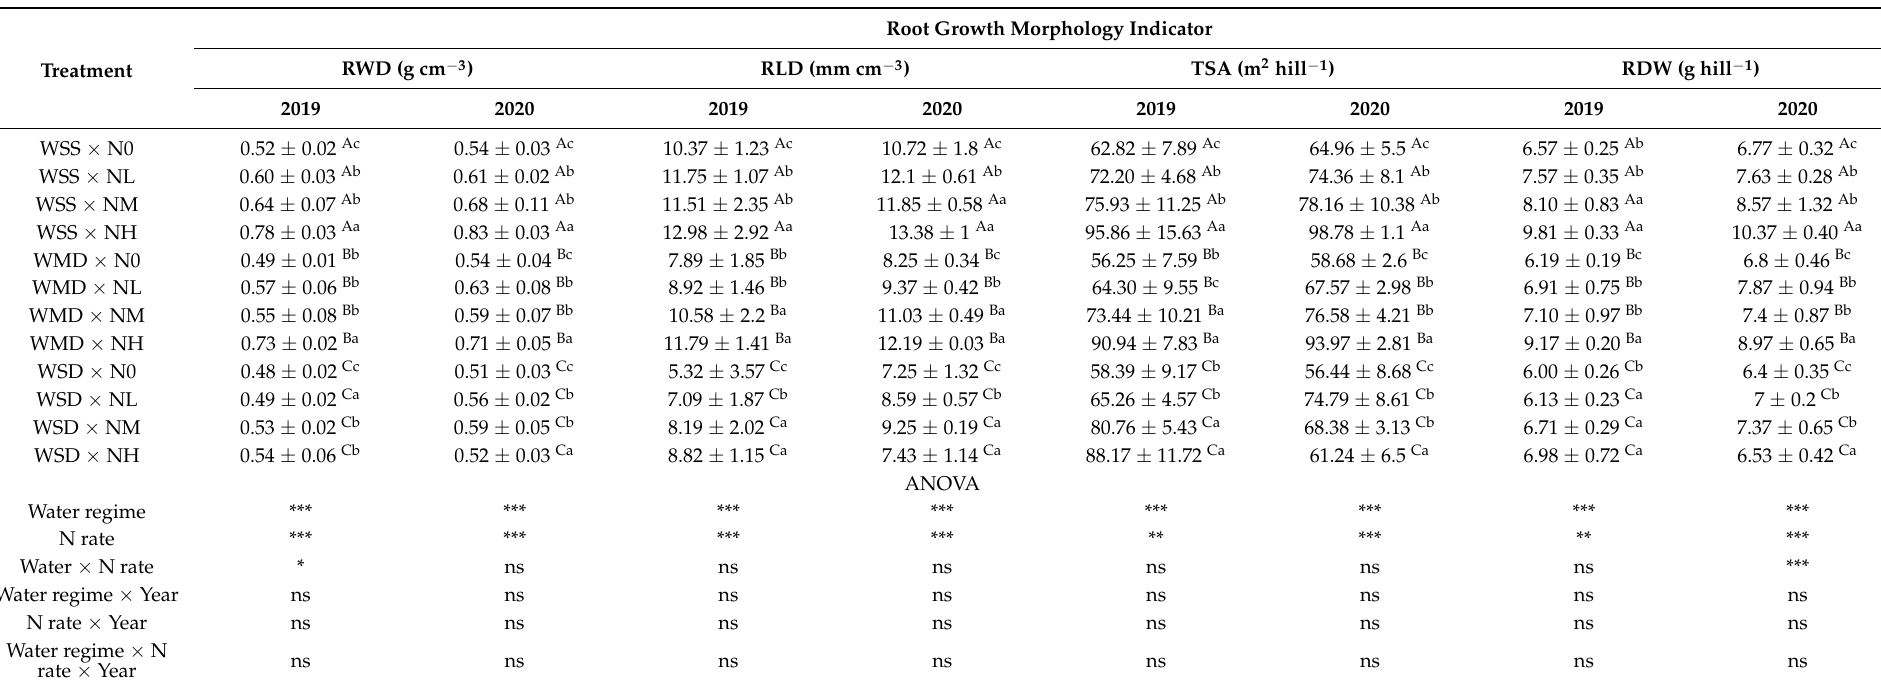
Table 2. Mean values of root morphology indicators for different irrigation methods and N fertilizer rates, and a summary of the ANOVA analysis of the main effects of different irrigation methods and N fertilizer rates on the rice root